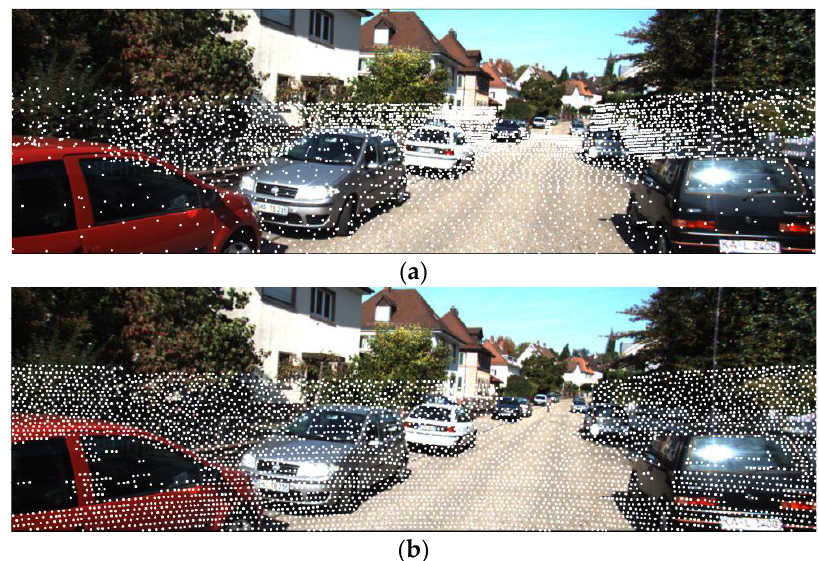
Figure 2. Comparison of ( a ) FPS and ( b ) P-FPS.